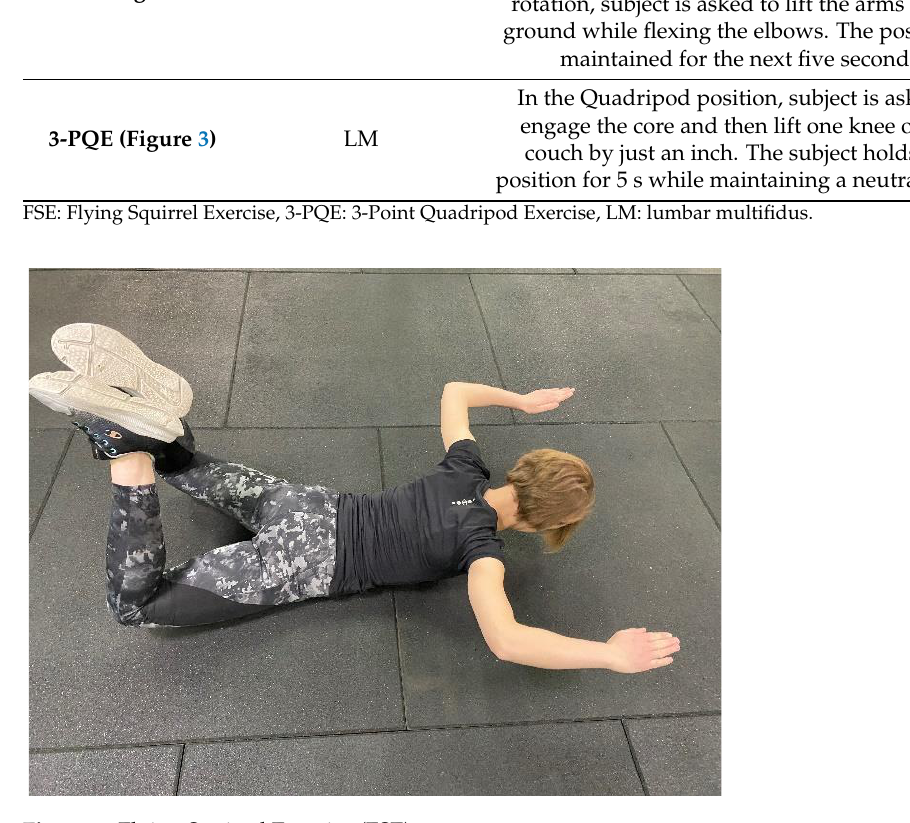
Figure 2. Flying Squirrel Exercise (FSE).